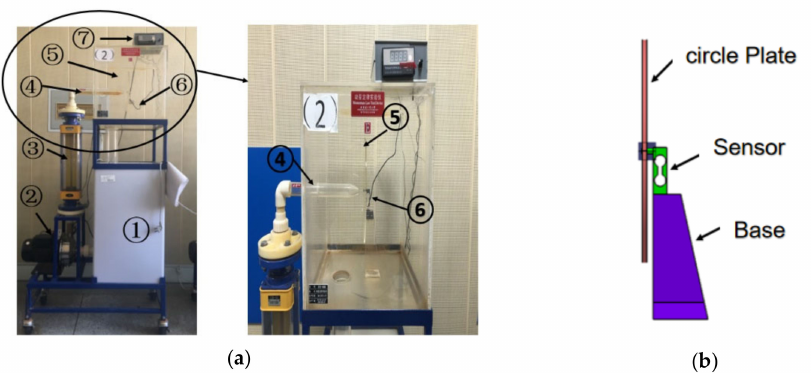
Figure 1. The structure graph of fluid momentum law test apparatus ( a ) the physical model of fluid momentum law test apparatus; ( b ) the core model of fluid momentum law test